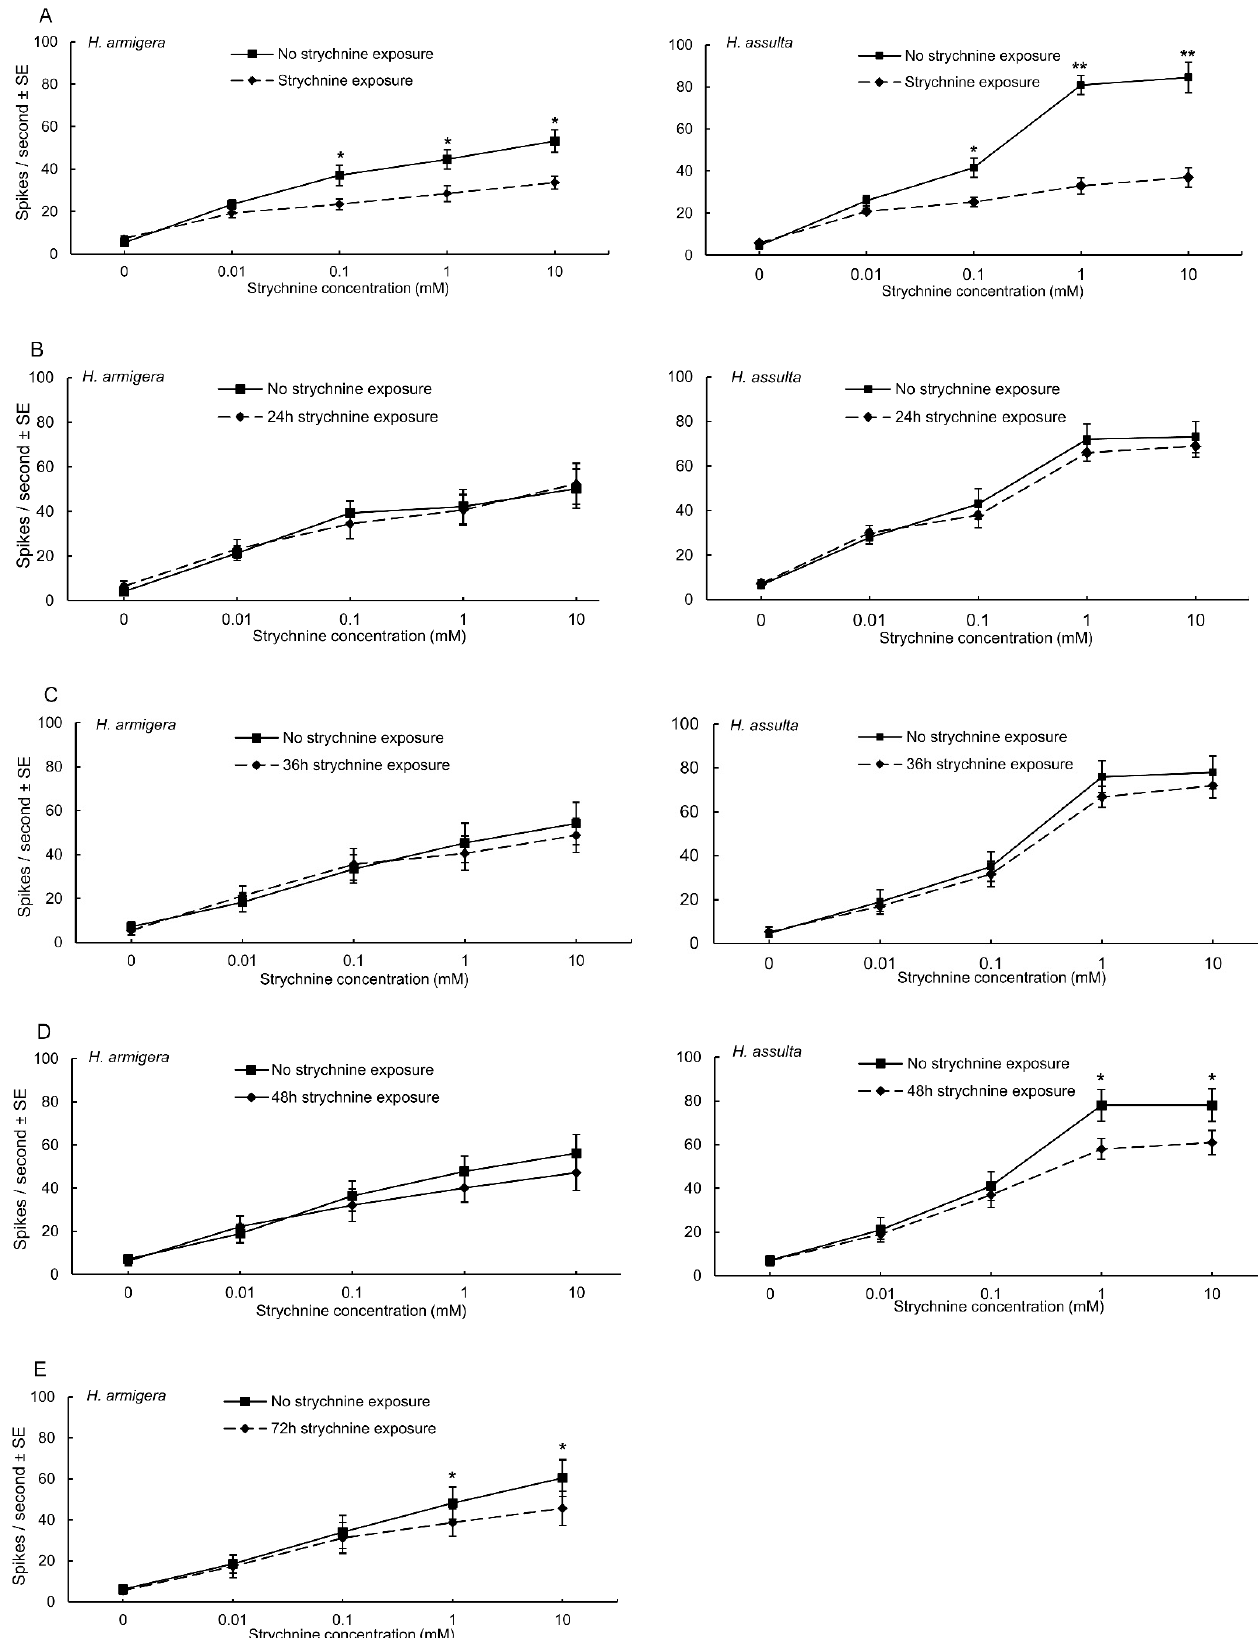
Figure 3. Electrophysiological dose-response curves for strychnine; spike frequencies of the